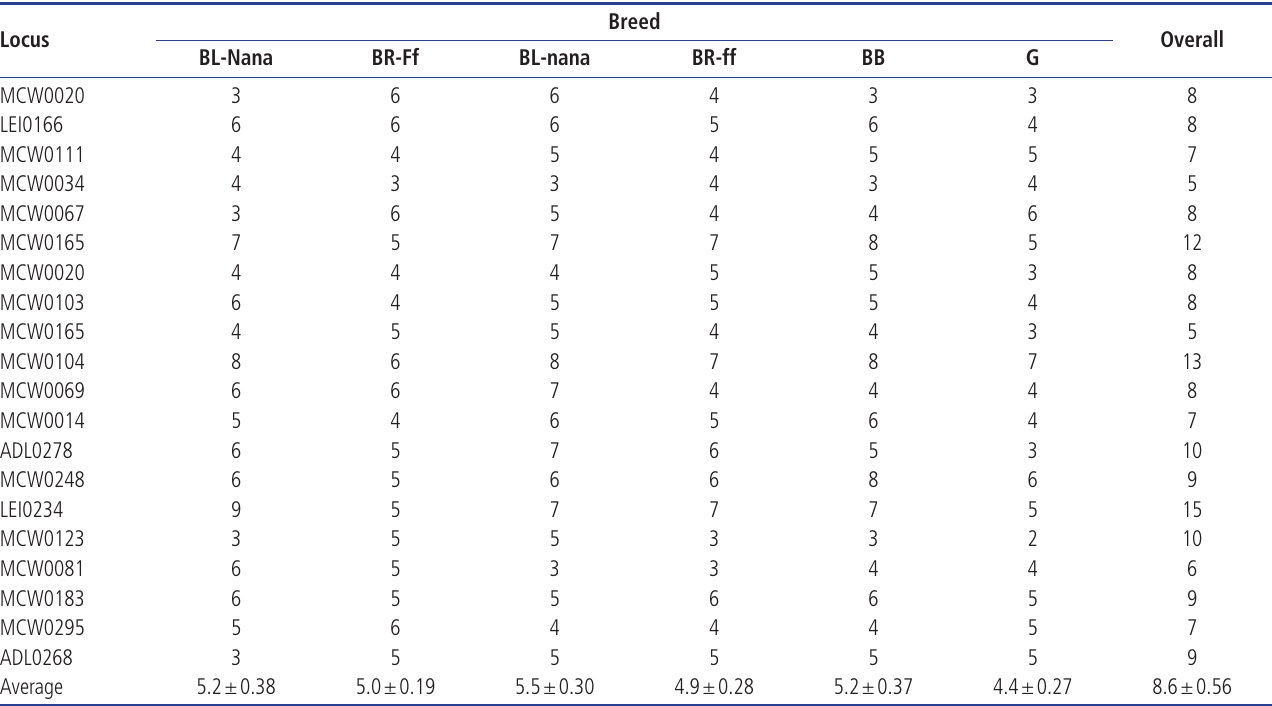
Table 3. Number of alleles per locus per chicken breed Locus